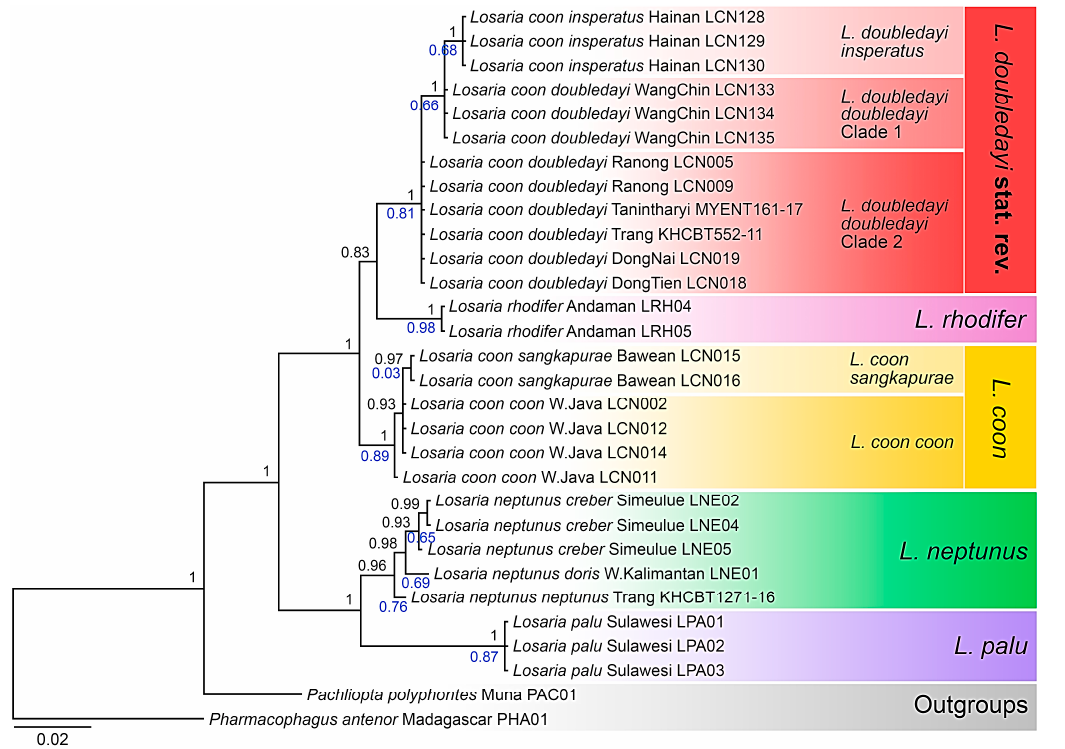
Figure 2. The Bayesian phylogenetic tree of genus Losaria (Moore, 1902) with Pharmacophagus antenor and Pachliopta polyphontes as outgroups. The branch tip labels of taxon names follow the current taxonomy, while the names in red colour blocks reflect changes proposed in this study. Black values at nodes indicate the posterior probability, and the blue values indicate the probabilities for Losaria taxa identified by the Bayesian–Poisson tree process model